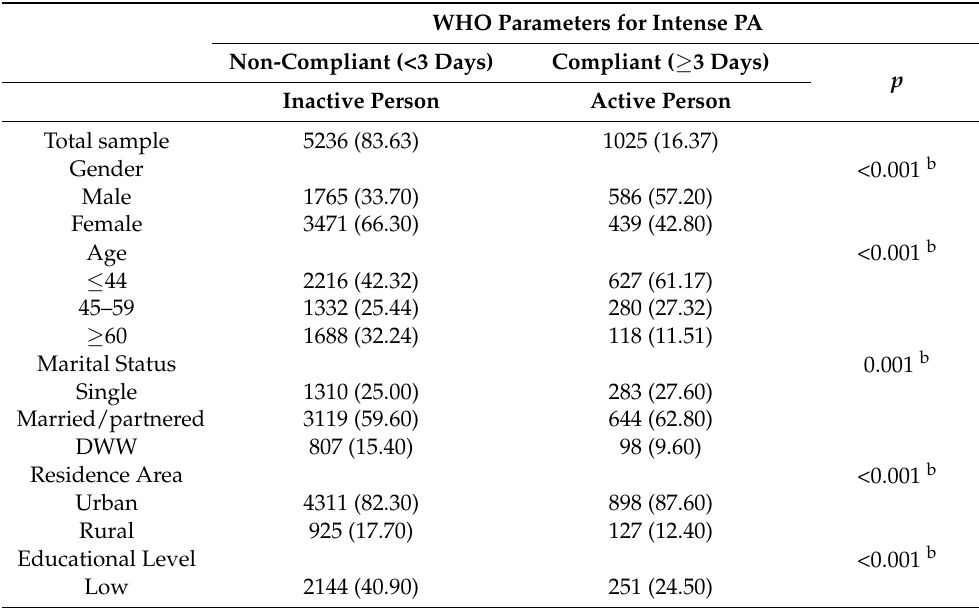
Table 2. Comparison of compliance with the WHO-designated parameters for intense PA (days) according to sociodemographic